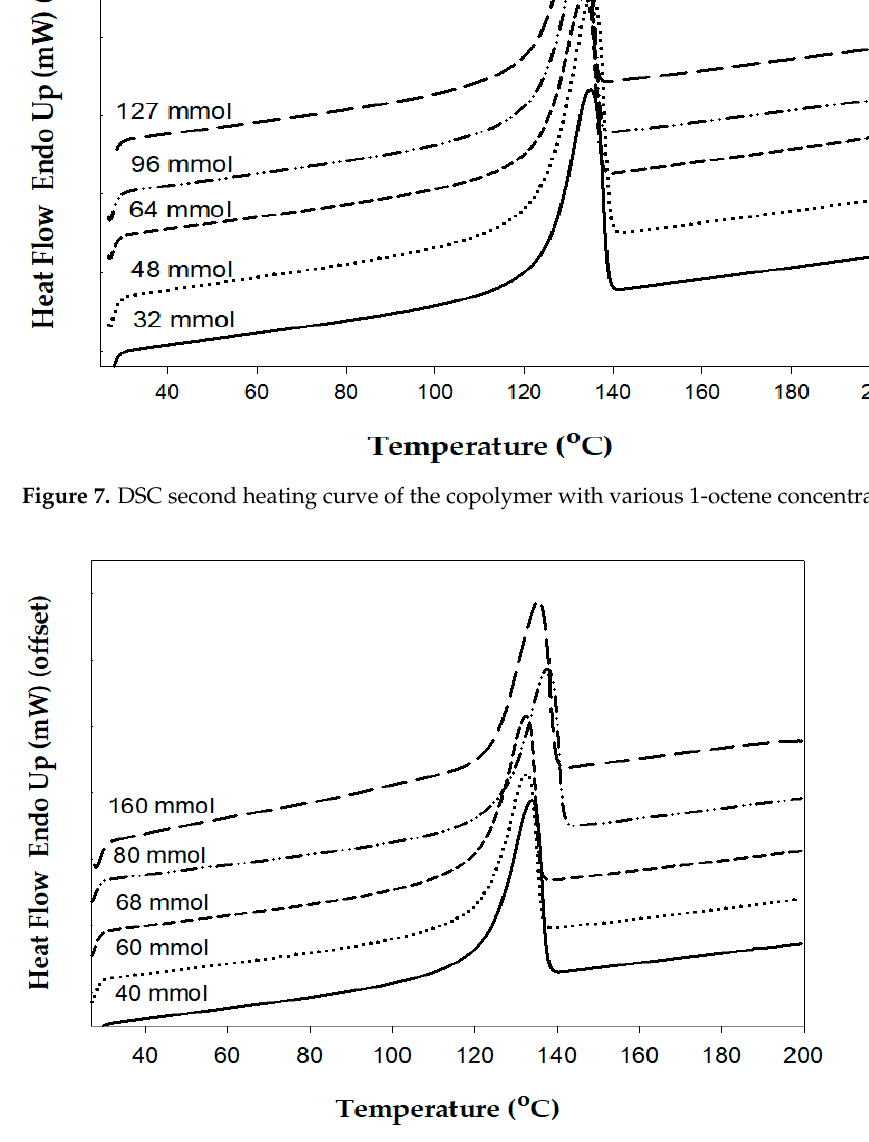
Figure 8. DSC second heating curve of the copolymer with various 1-hexene concentrations.